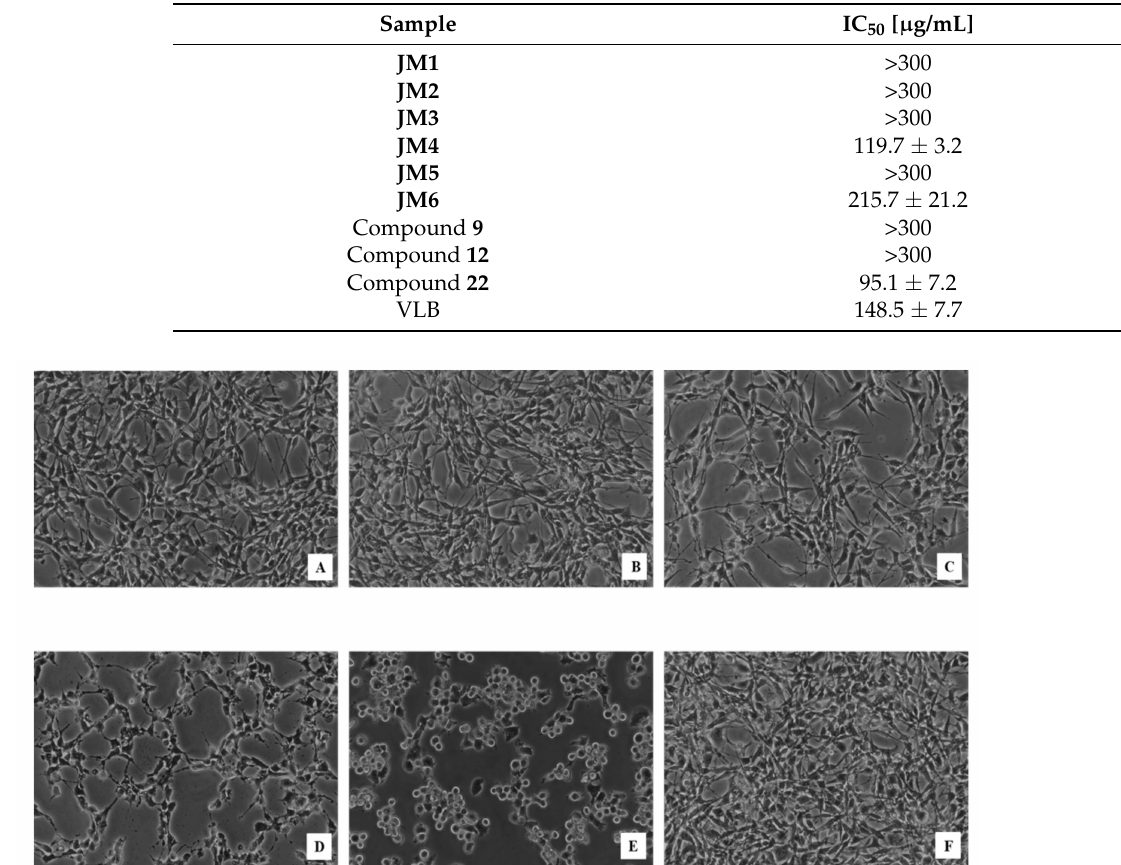
µ g/mL). 50 value in